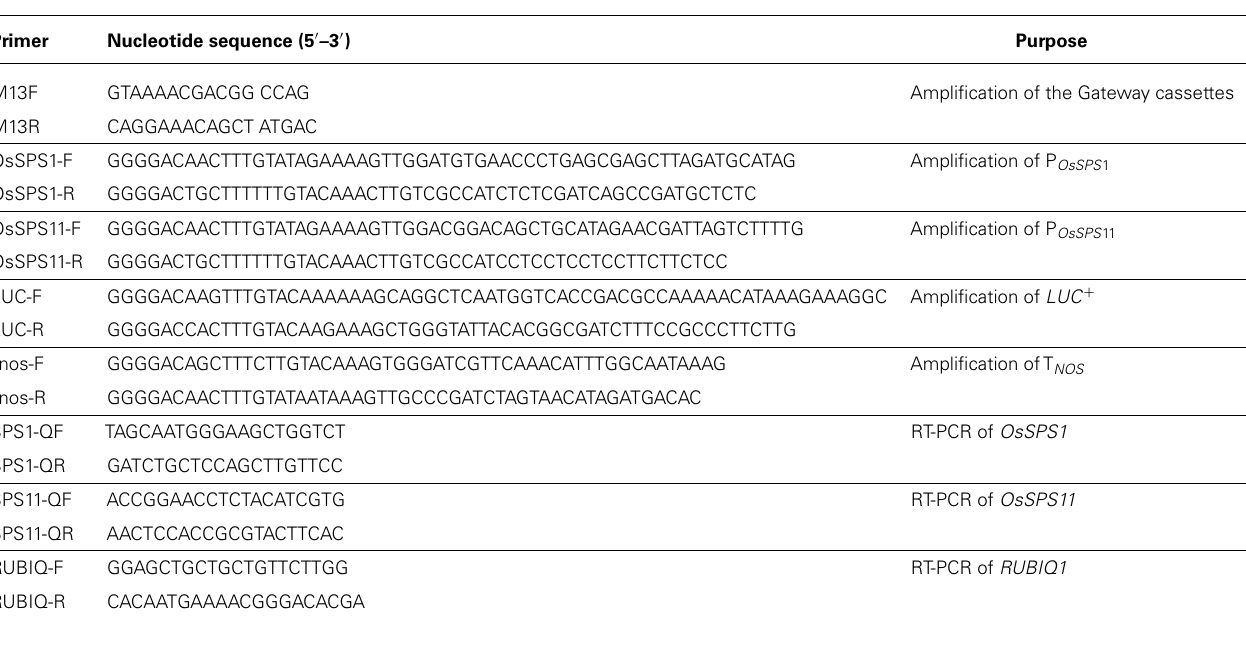
Table 1 | Primer sequences used in this